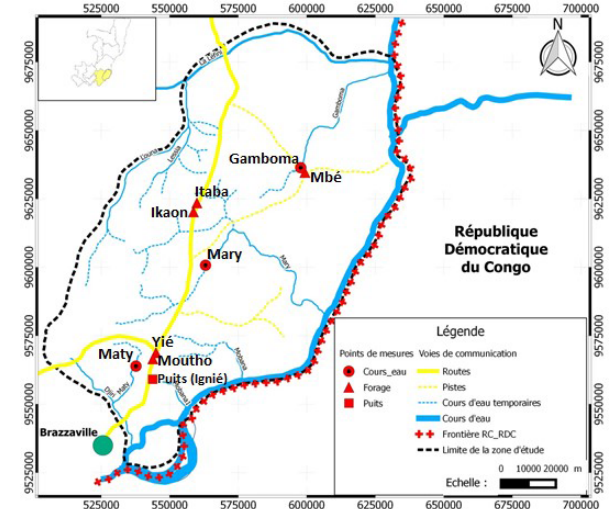
Figure 1. Localisation de la zone d’étude et les points de prélève- ments.